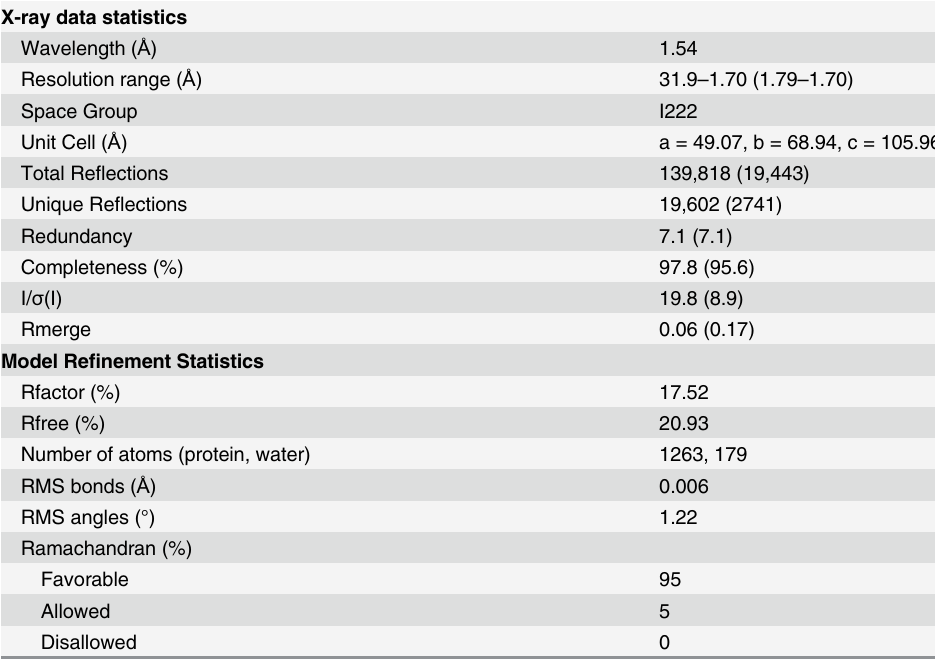
Table 1. X-ray data collection and model re fi nement